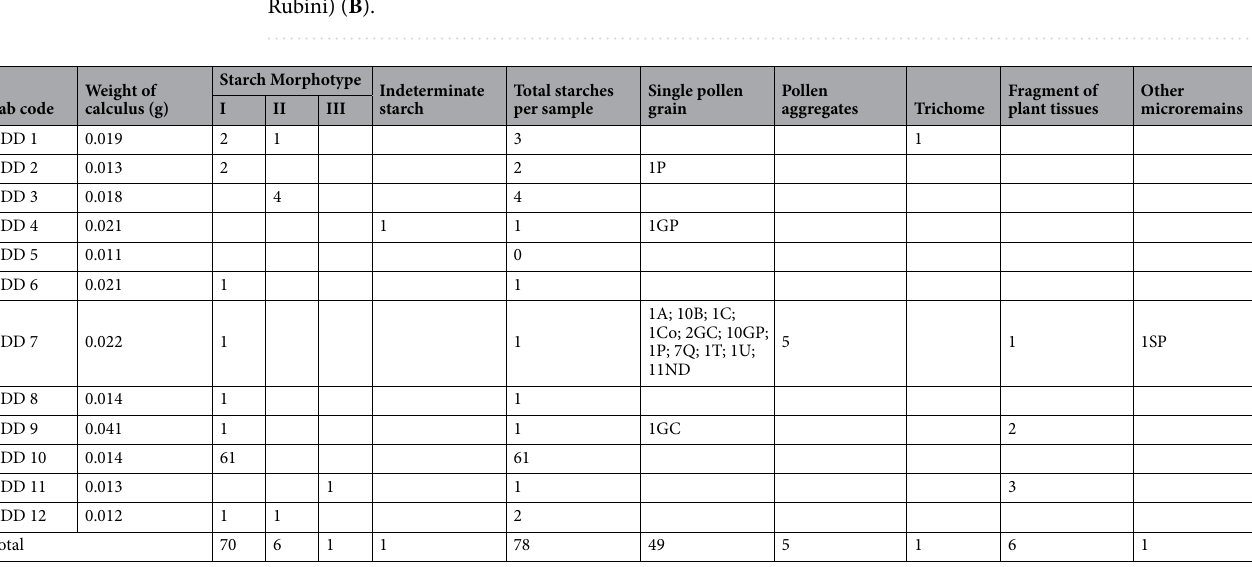
Table 1. Plant microdebris recovered from dental calculus samples of Casale del Dolce . Amount and proposed identification of microparticles detected by light microscopy. Legend for pollen: A, Alchemilla -type; B, Brassicaceae; C, Cyperaceae; Co, Corylus avellana ; Q, Quercus deciduous; GC, Cupressaceae; GP, Pinaceae; P, Poaceae spontaneous group; T, Trifolium -type; U, Urticaceae; ND, not determined; SP, sporangium. The weight of each dental calculus sample was reported in